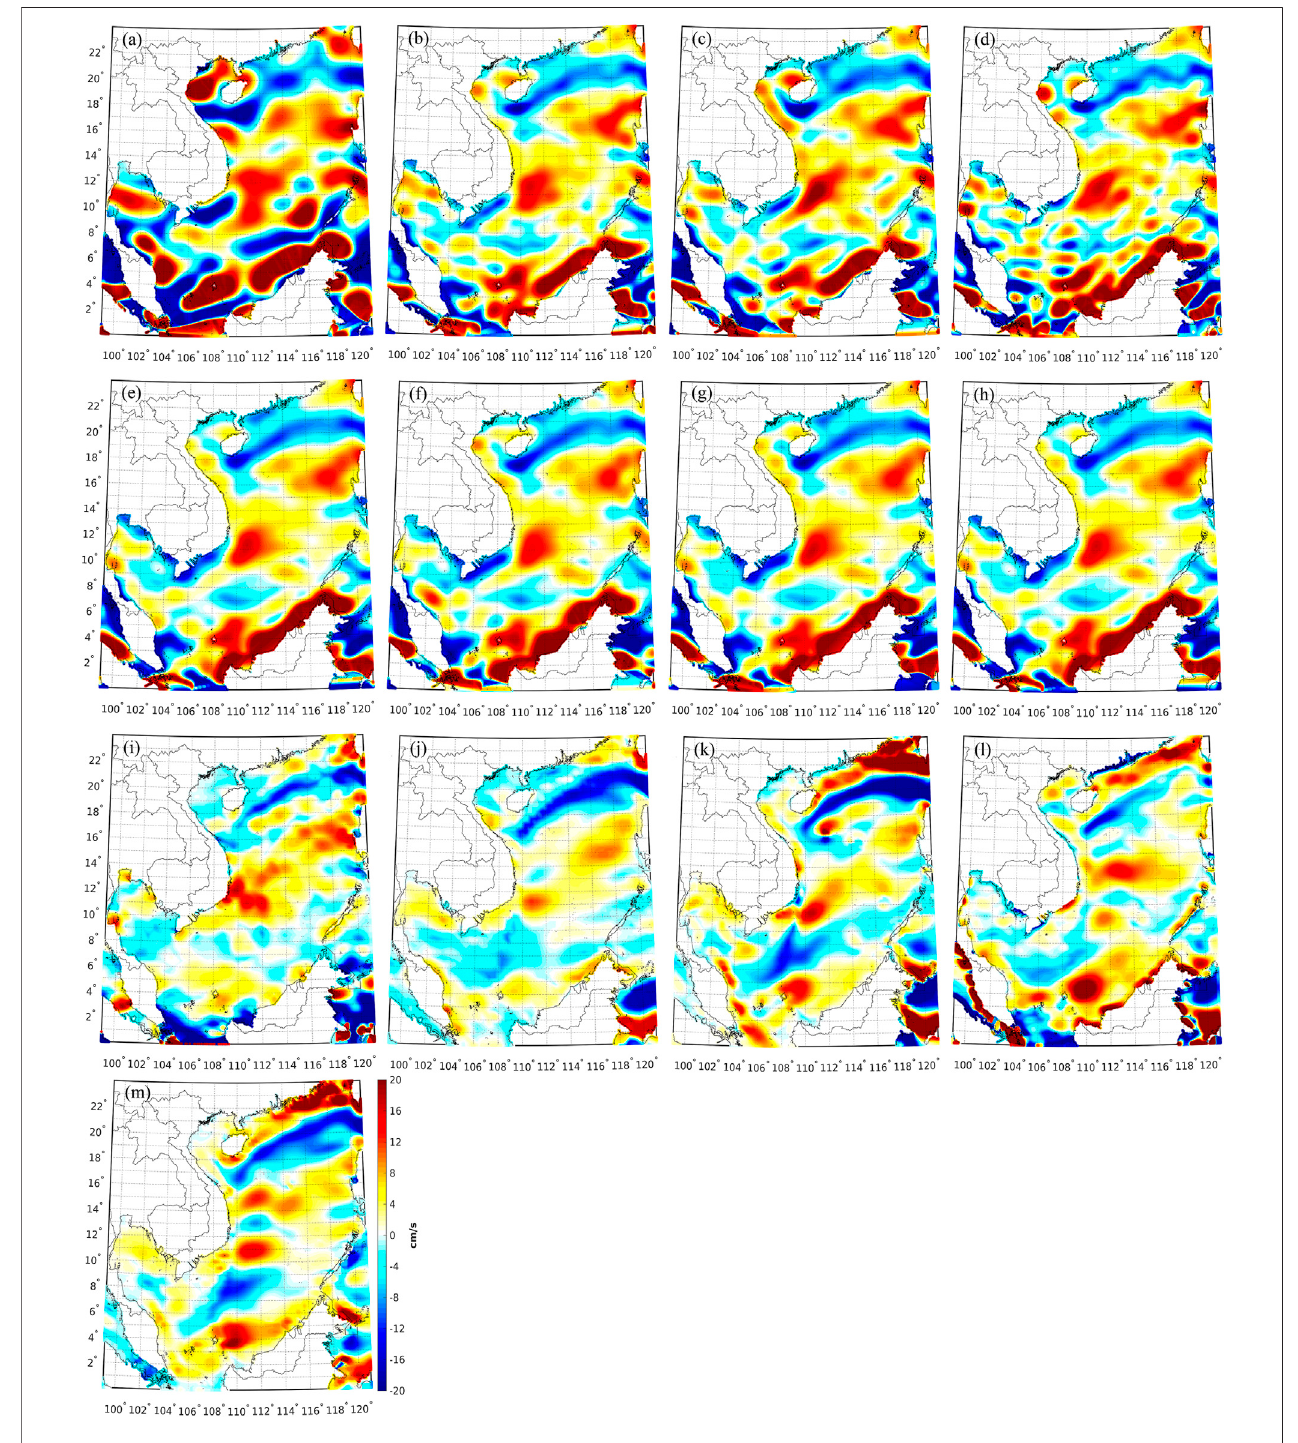
FIGURE10| ZonalgeostrophicvelocitiesderivedfromtheMDTcomputedfrom (A) EGM2008, (B) GECO, (C) SGG-UGM-1, (D) EIGEN-6C4, (E) XGM2019_2159, (F) GOCO05c, (G) XGM2016, (H) XGM2019, (I) CNES-CLS13MDT; and zonal velocities retrieved from (J) SODA, (K) ORAS5, (L) OCCAM, and (M) AIPO.